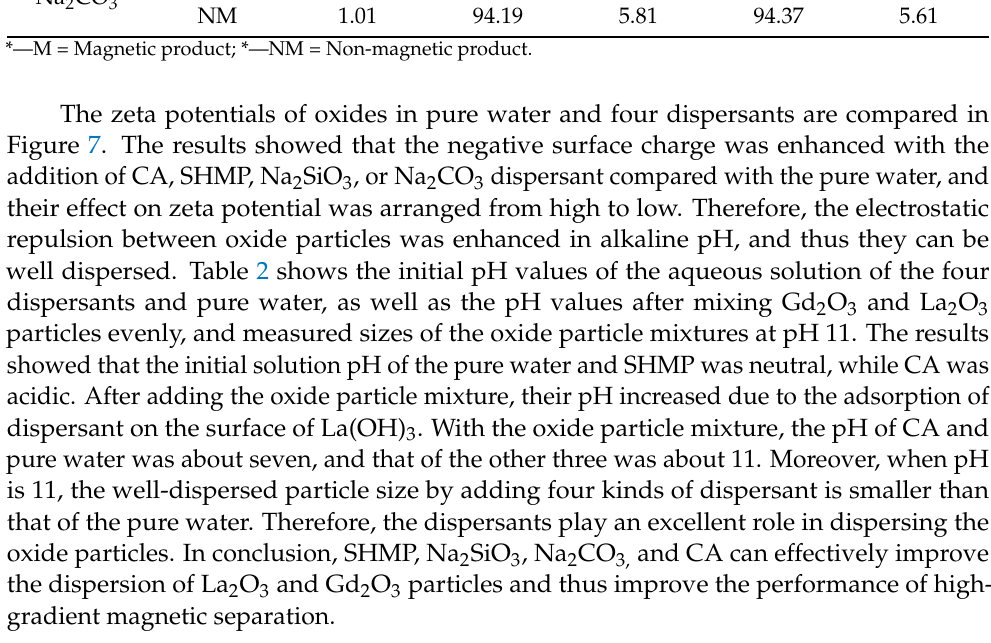
Table 2. The pH of four dispersants before and after adding oxide particles and the size of particle mixture at pH